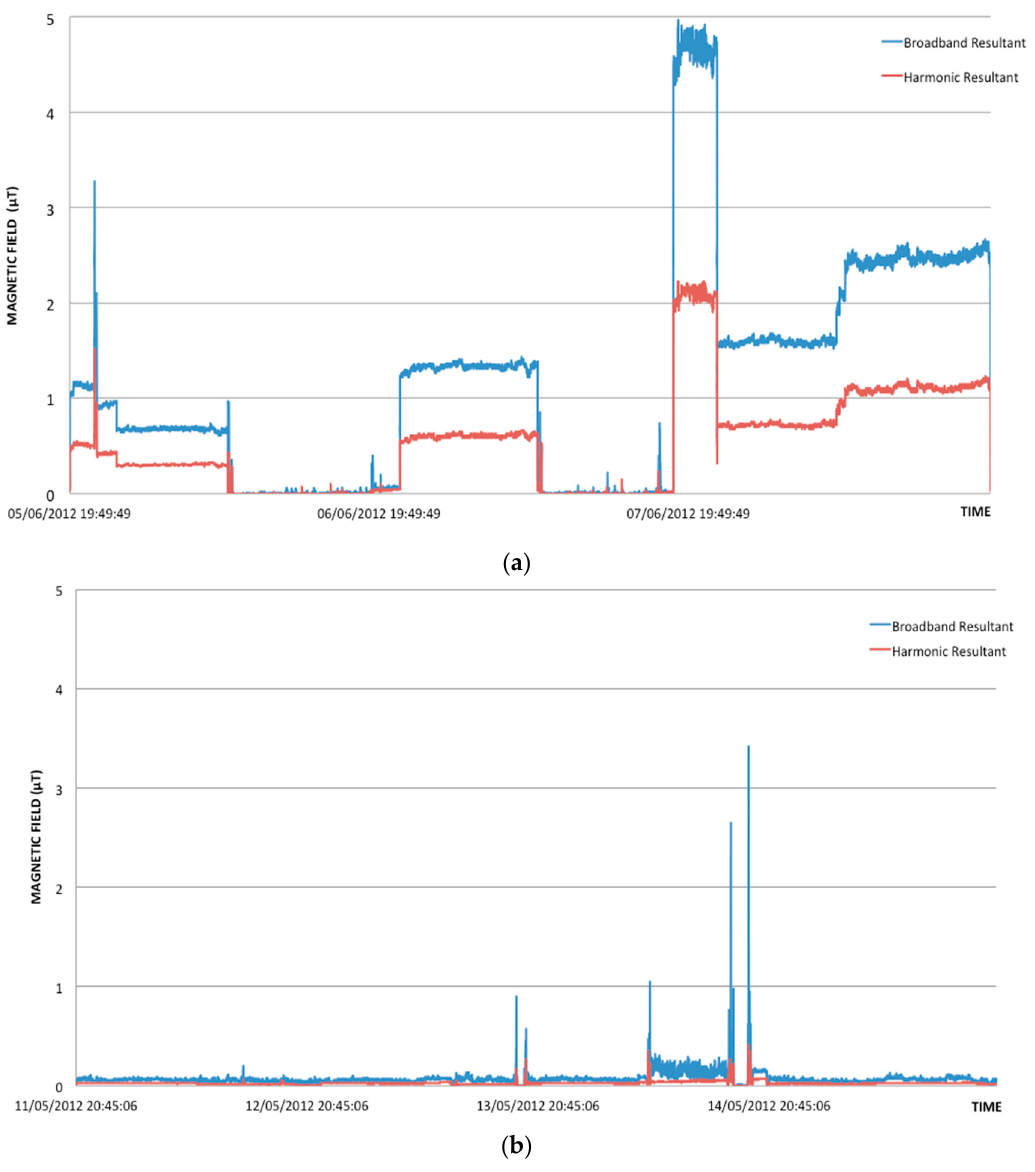
Figure 5. Examples of exposure measurements. ( a ) Trend of the magnetic field ( μ T) measurements over time performed by a child within the OTHER group during the summer period, in which high exposure has been observed; ( b ) typical trend of magnetic field measurements over time of another child always belonging to the OTHER group performed in the summer period as well. Table 4. Model coefficients of the chosen variables (study group, season, and measurement type) for the target variables (median, geometric mean, and arithmetic mean).